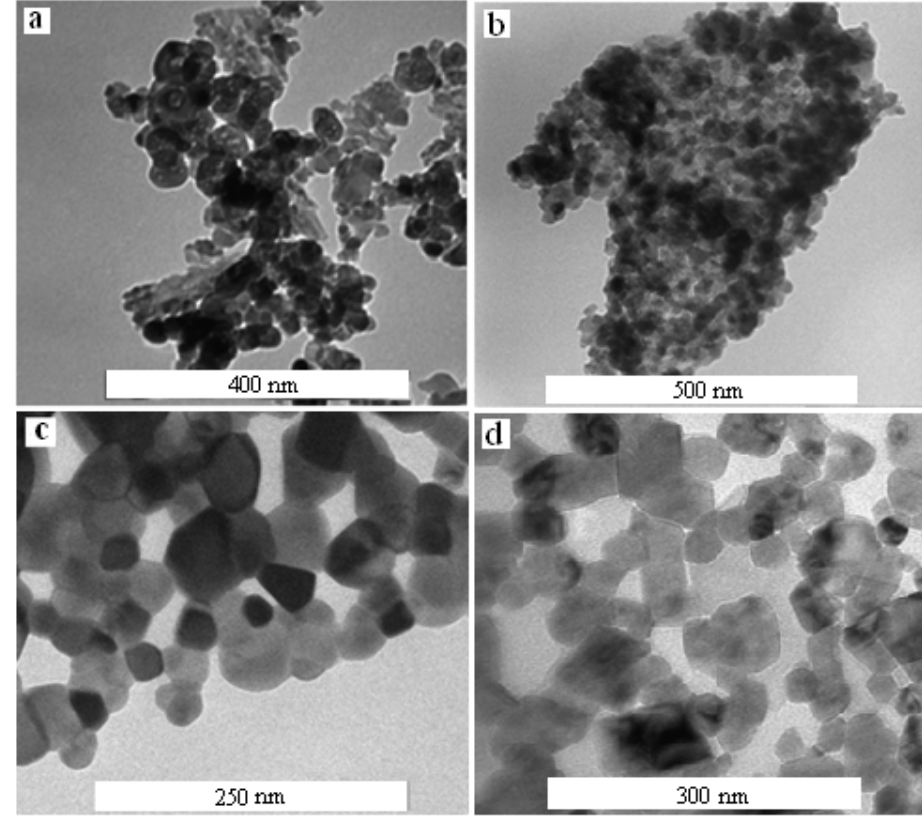
Figure 4. TEM images of zinc ferrite nanoparicles with concentration of ( a ) 0, ( b ) 15, ( c ) 40, and ( d ) 55 g/L, which calcined at 873